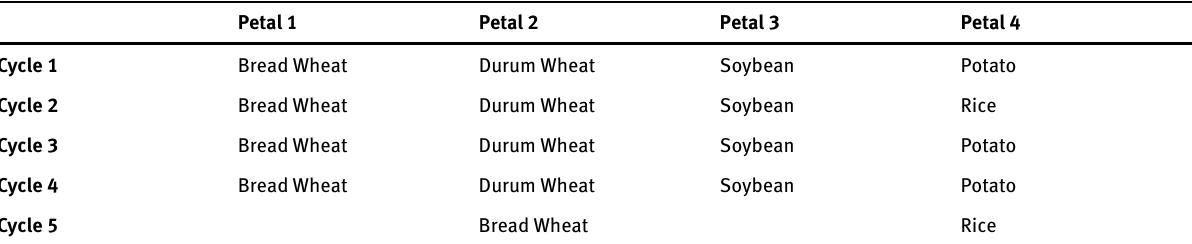
Table 3: Plant allocation in petals during